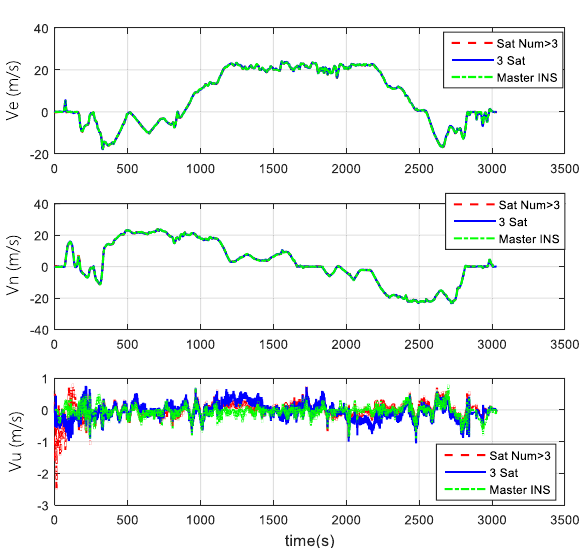
Figure 12. Velocity comparison of navigation by normal number of satellites and 3